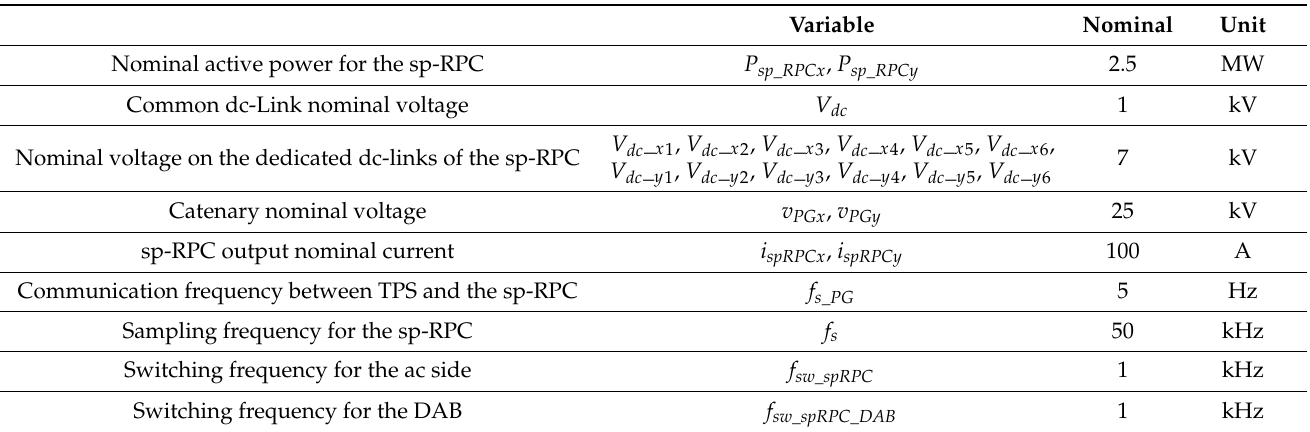
Table 1. Main parameters of the topology.